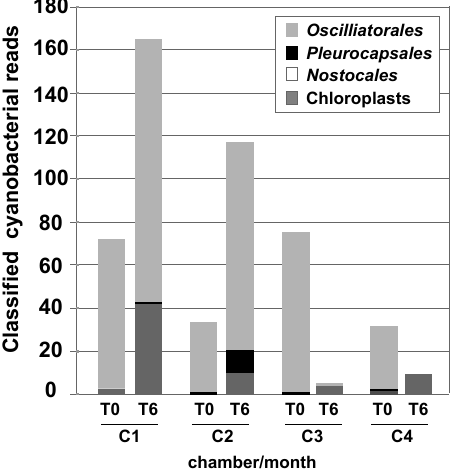
Figure 3. Classified cyanobacterial sequences from OTUs that could be assigned to a specific order by a Bayesian approach at a confidence interval ≥ 70%. The cyanobacterial populations were compared at the start (T0) and at the end of the six-month incubation (T6). The environmental treatments include: C1, 400 ppmv CO 1200 ppmv CO and 35‰ salinity; C3, 400 ppmv CO 2 and 85‰ 1200 ppmv CO 2